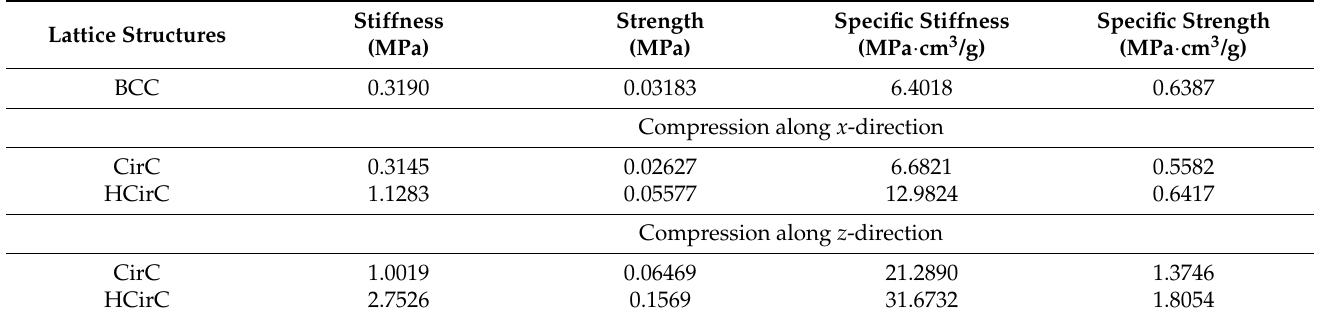
Table 2. Compression mechanical properties of lattice structures BCC, CirC, and